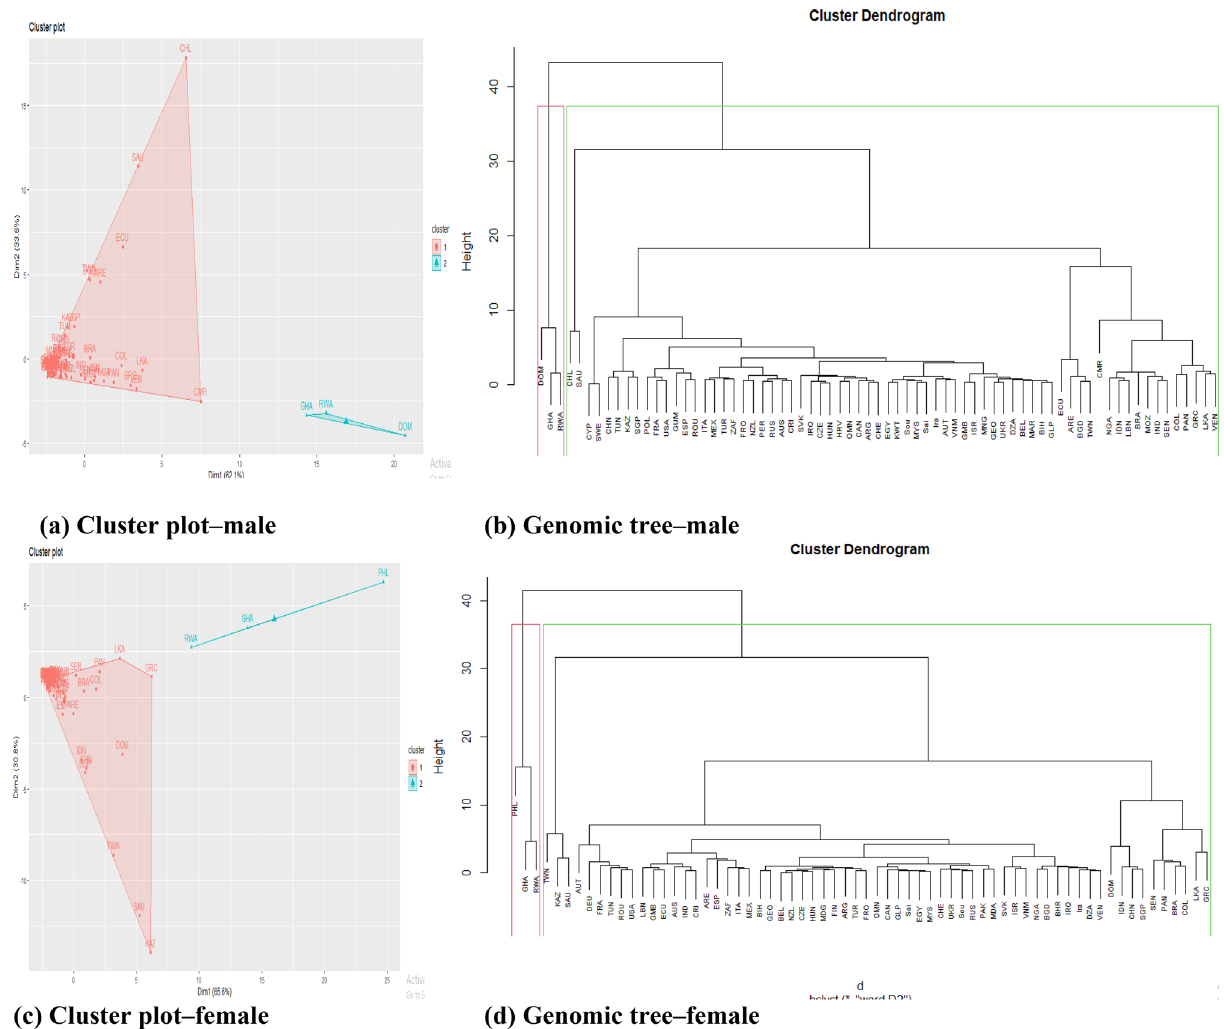
Figure 12. Cluster plots and genomic trees. Notice 2 distinct groups (or clusters) A and B separated between closely similar and dissimilar isolates, with the A group having heavy isolates concentration than the B group. For males ( b ), group A consists of 68 isolates with 7 sub-groups as follows: 1 (CHL, SAU); 2 (CHN, TUN, KAZ, SGP, POL, FRA, USA, GUM, ESP, ROU); 3 (ITA, MEX, TUR, ZAF, FRO, NZL, PER, RUS, AUS, CRI); 4 (SVK, IRQ, CZE, HUN, HRV, OMN, CAN, ARG, CHE, EGY, KWT, SOU, MYS, SAI, Iran, AUT, VNM, GMB, ISR, MNG, GEO, UKR, DZA, BEL, MAR, BIH, GLP); 5 (ECU, ARE, BGD, TWN); 6 (CMR, NGA, IDN, LBN, BRA, MOZ, IND, SEN, COL, PAN, GRC, LKA, VEN). Group B consists of 1 sub-group as follows: 1 (DOM, GHA, RWA). For Females ( d ), group A consists of 63 isolates with 6 sub-groups as follows: 1 (TWN, KAZ, SAU); 2 (AUT, DEU, FRA, TUN, ROU, USA); 3 (LBN, GMB, ECU, AUS, IND, CRI, ARE, ESP, ZAF, ITA, MEX); 4 (BIH, GEO, BEL, NZL, CZE, HUN, MDG, FIN, ARG, TUR, FRO, OMN, CAN, GLP, SAI, EGY, MYS, CHE, UKR, SOU, RUS, PAK, MDA, SVK, ISR, VNM, NGA, BGD, BHR, IRQ, Iran, DZA, VEN); 5 (DOM, IDN, CHN, SGP); 6 (SEN, PAN, BRA, COL, LKA,